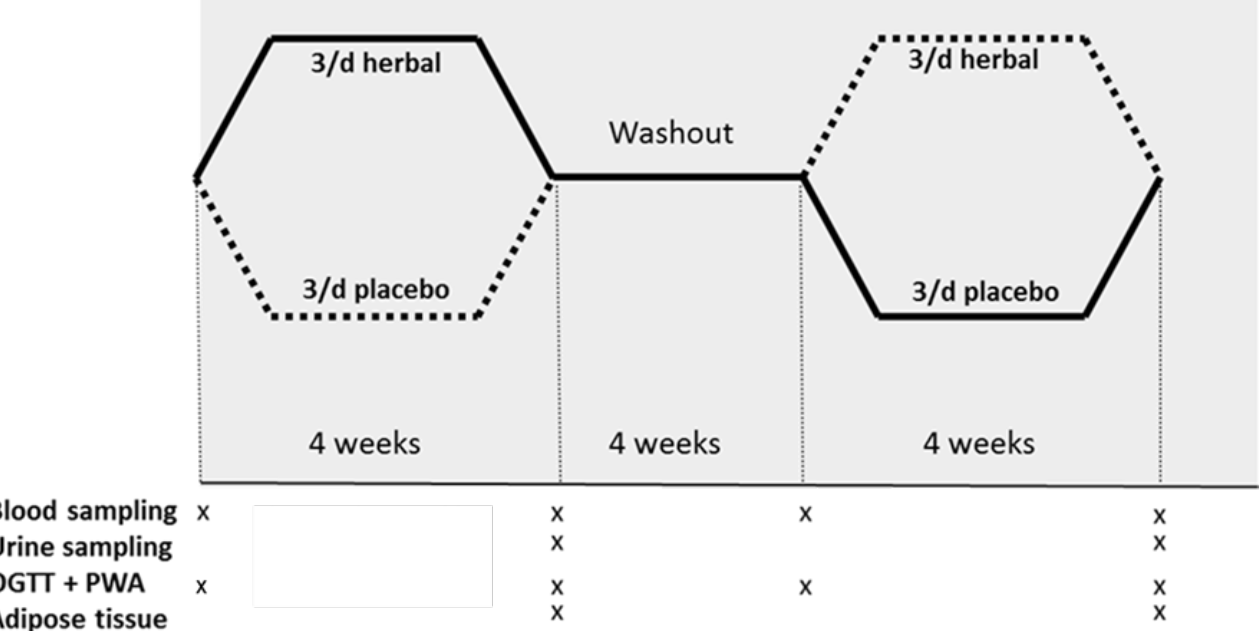
Figure 1. Study design: double-blind, placebo-controlled cross-over 4-week intervention trial in 22 middle-aged subjects with impaired glucose tolerance. Subjects consumed, in random order, four weeks herbal and four weeks placebo supplements three times a day. OGTT; oral glucose tolerance test, PWA; pulse wave analysis. Table 1. Herbs and the amounts (%) used in the herbal supplements and their potentially health effect described in the